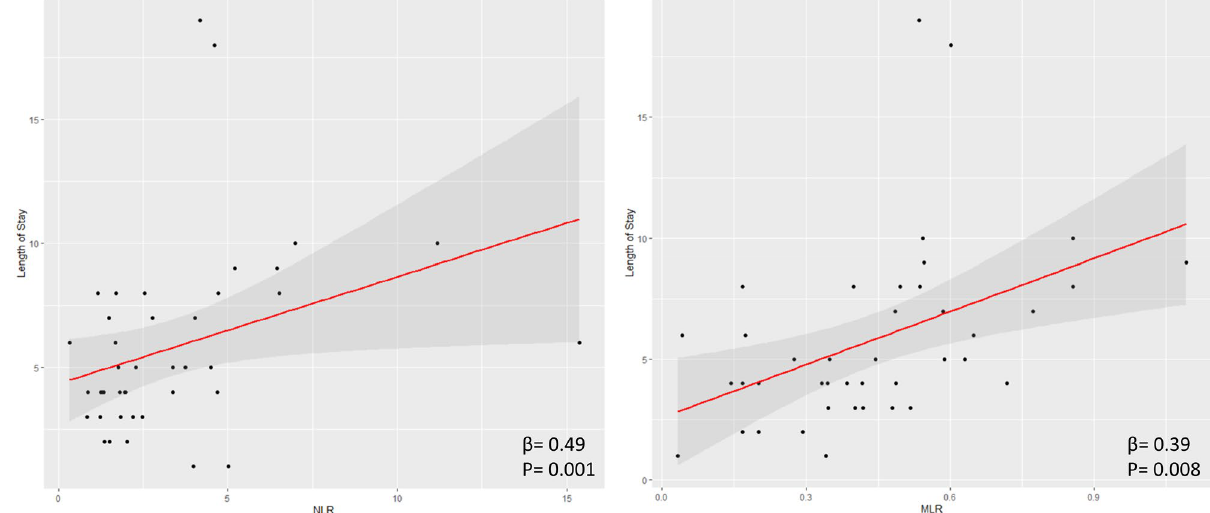
Figure 1. Univariate linear regression analysis of NLR and MLR with length of hospital stay. Abbreviations: NLR = neutrophil-to-lymphocyte ratio, MLR = monocyte-to-lymphocyte ratio.